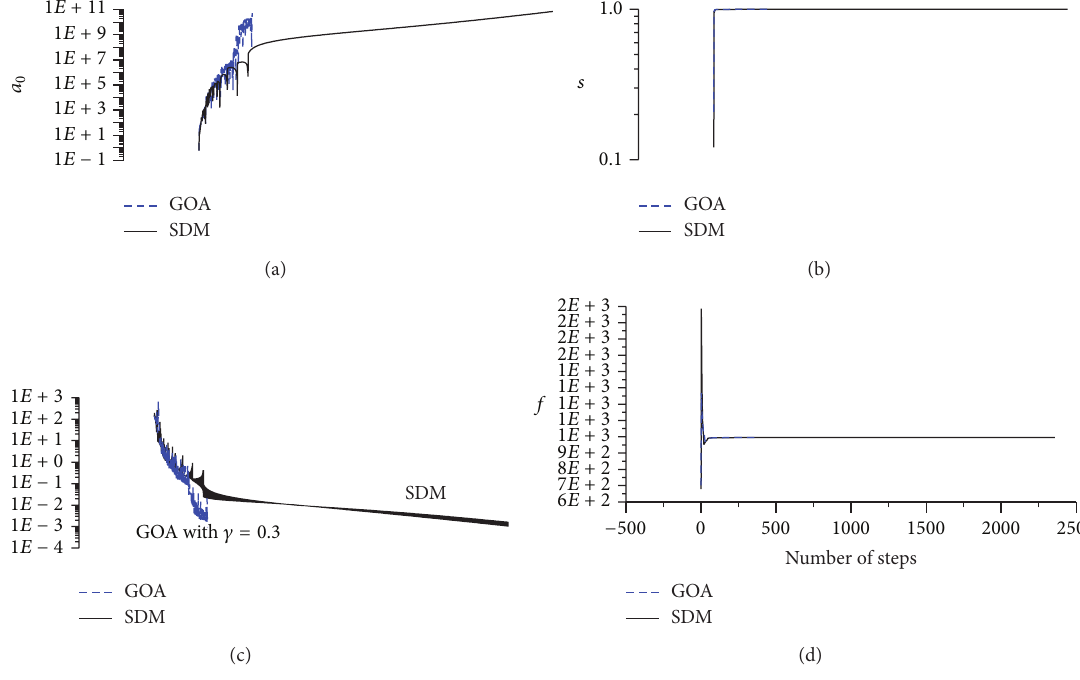
large, which means that the quasi-Newton direction is a dominant factor to accelerate the convergence